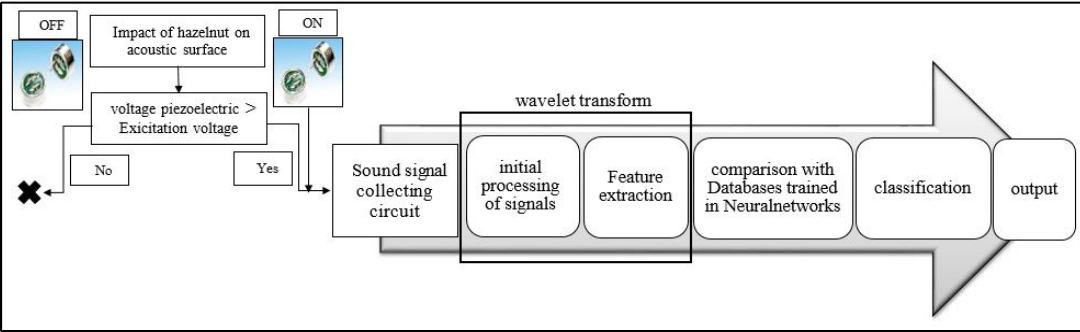
Figure 9. Block diagram of system software.